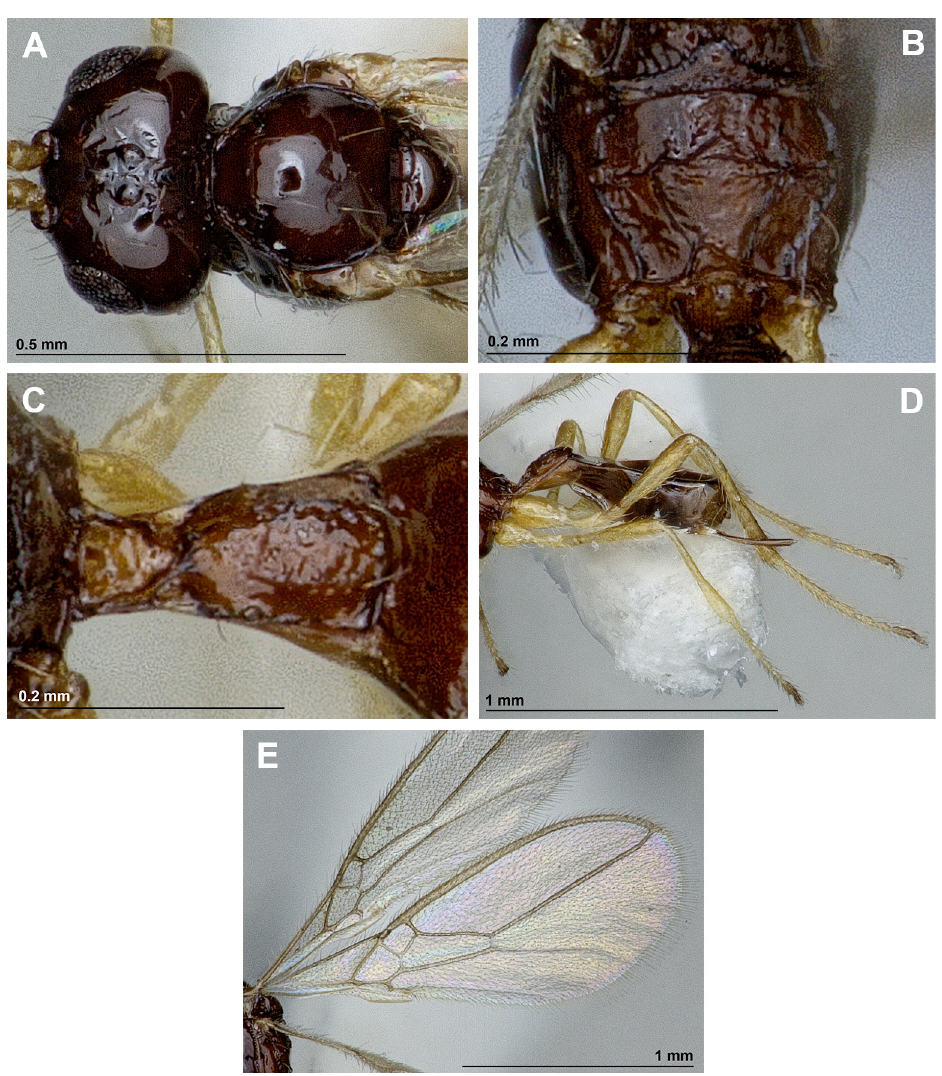
Fig. 5. Aspilota leptoarticulata Munk & Peris-Felipo sp. nov. (♀). A . Head and mesonotum, dorsal view. B . Propodeum, dorsal view. C . First metasomal tergite, dorsal view. D . Hind leg, metasoma and ovipositor. E . Fore